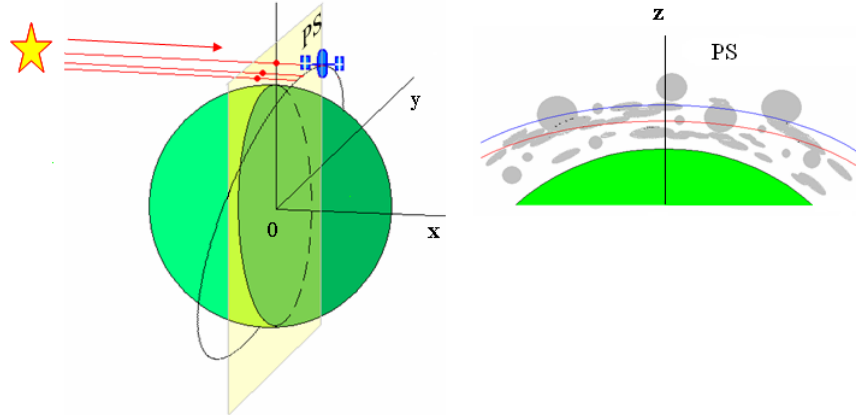
Figure 1. Left: the scheme of red rays observations: the phase screen plane (PS, highlighted in yellow) is in the plane y 0 z , which is perpendicular to incident rays. Right: trajectories of rays in the phase screen: the trajectories of red and blue rays are separated vertically by the chromatic shift 1 c . Atmospheric irregularities are schematically shown by gray circles and ellipses.